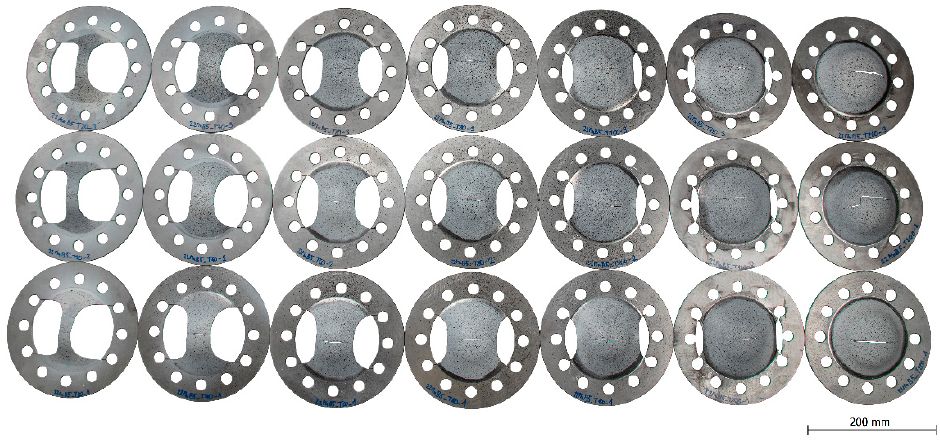
Figure 5. The Nakajima specimen geometries manufactured according to standard ISO 12004 (from the left: 20-, 40-, 60-, 80-, 100-, 120- and 200-mm width) after testing.